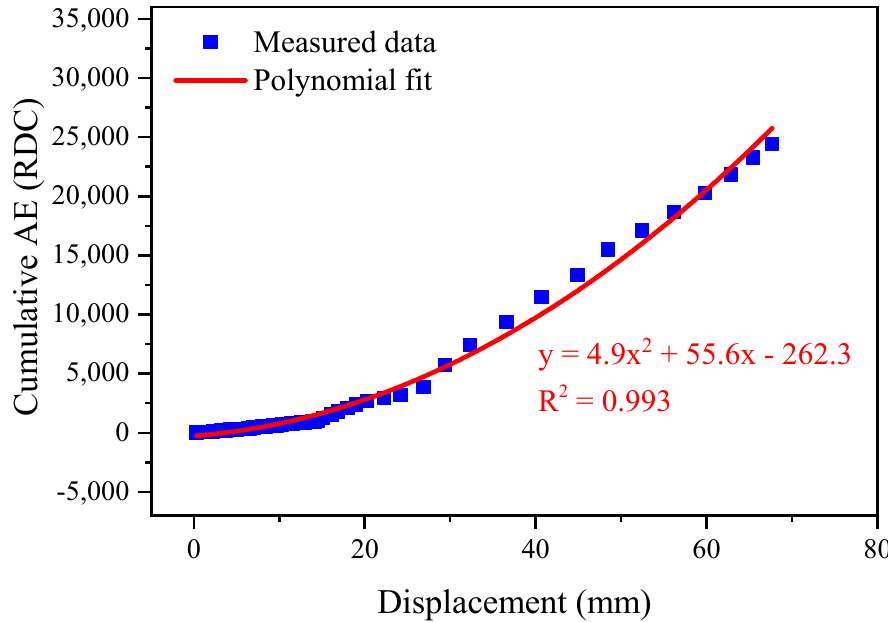
Figure 8. Sliding displacement and cumulative ring down count (RDC) plotted against time.